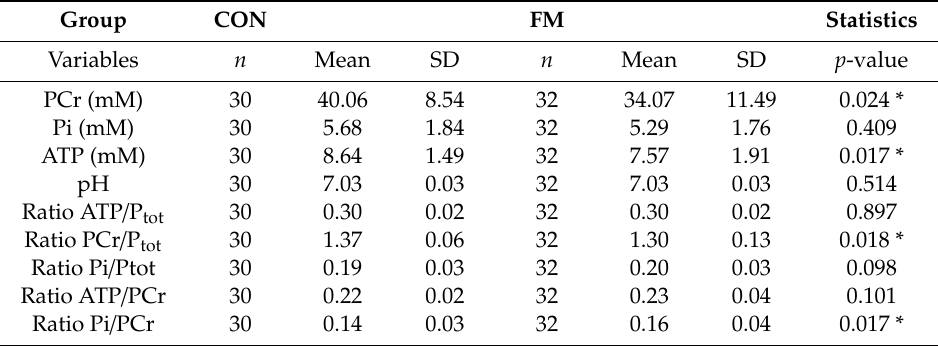
Table 4. Results obtained from spectroscopy examination of the erector spinae muscle. Group CON FM Statistics Variables